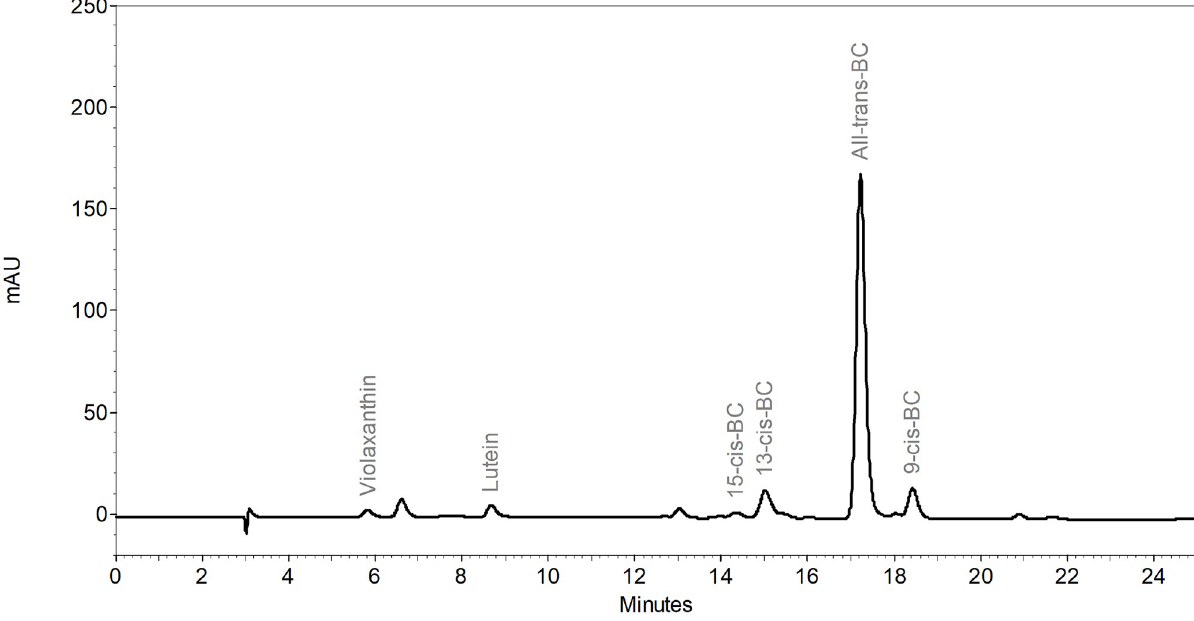
Fig 1. HPLC chromatogram for cassava storage roots (detection at 450 nm). HPLC conditions are described in the text. https://doi.org/10.1371/journal.pone.0209702.g001 Table 1. TCC and trans-BC in fresh cassava samples measured by HPLC, spectrophotometer, iCheck Carotene, dNIRS, and